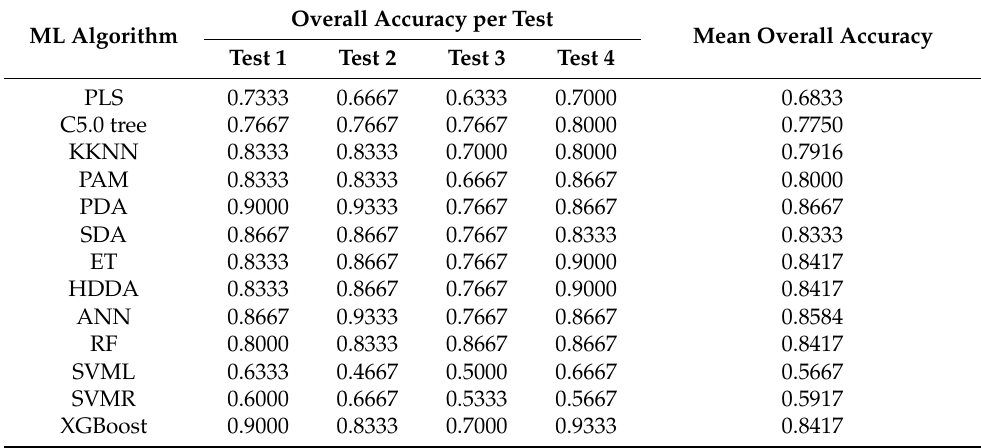
Table 5. Overall accuracy of ML models for classification of honey samples in the test